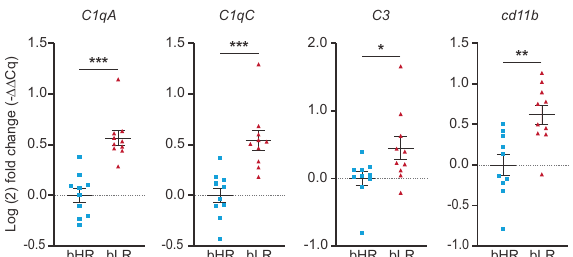
(MicroBrightField Bioscience). Cells were selected from systematically placed circular regions of interest (ROI) within CA1, CA3, and DG on a single section per subject ( n = 8/line). Five cells were selected per ROI (total: 40 cells /ROI/line). Individual rami fi ed cells were selected based on a visible full cell body that was distinguishable from nearby cells, with no major disconnections of processes. Using a 63x-oil objective (1.32 numerical aperture), the edge of the cell body was fi rst traced at a single plane of focus. Each process was then traced, with both the width of the process and plane of focus adjusted incrementally, until all visible processes were reconstructed. Reconstructions were analyzed using Neurolucida Explorer Software (MicroBrightField Bioscience). During data processing, 4 cells (two from bHRs; two from bLRs) were identi fi ed as extreme outliers in multiple measures (Grubb ’ s test, p < 0.05) and therefore removed from the analyses ( fi nal n = 38 cells/line). Statistical analysis All data were analyzed with SPSS v26 (IBM, Armonk, NY). Equality of variance was assessed using either Levene ’ s or Mauchly ’ s test. For qPCR data, − ΔΔ Cq values were analyzed using Welch ’ s independent t -tests due ni fi cant interactions were explained using simple-effects analyses. For the bLR-only minocycline study, independent t -tests (two-tailed) compared treatment groups. For Iba1 analyses, data were fi rst analyzed with mixed- factors ANOVAs to determine if the effects of line varied across sub-region analyzed (CA1, CA3, DG). In the presence of a signi fi cant interaction, results were analyzed and presented separately for each sub-region. Line differences in Iba1 measures were determined using independent samples t -tests (two-tailed), with Bonferroni correction where appropriate. Full statistical values are presented in Supplemental Materials (Tables S2 – S8) and in Figure Legends.